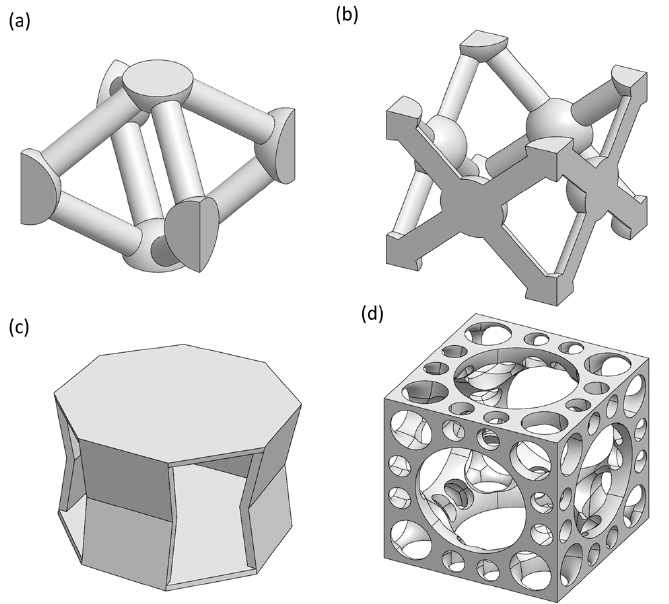
Figure 5. UC CAD models for the topologies: ( a ) BCC; ( b ) FCC; ( c ) AUX; ( d ) ORG.